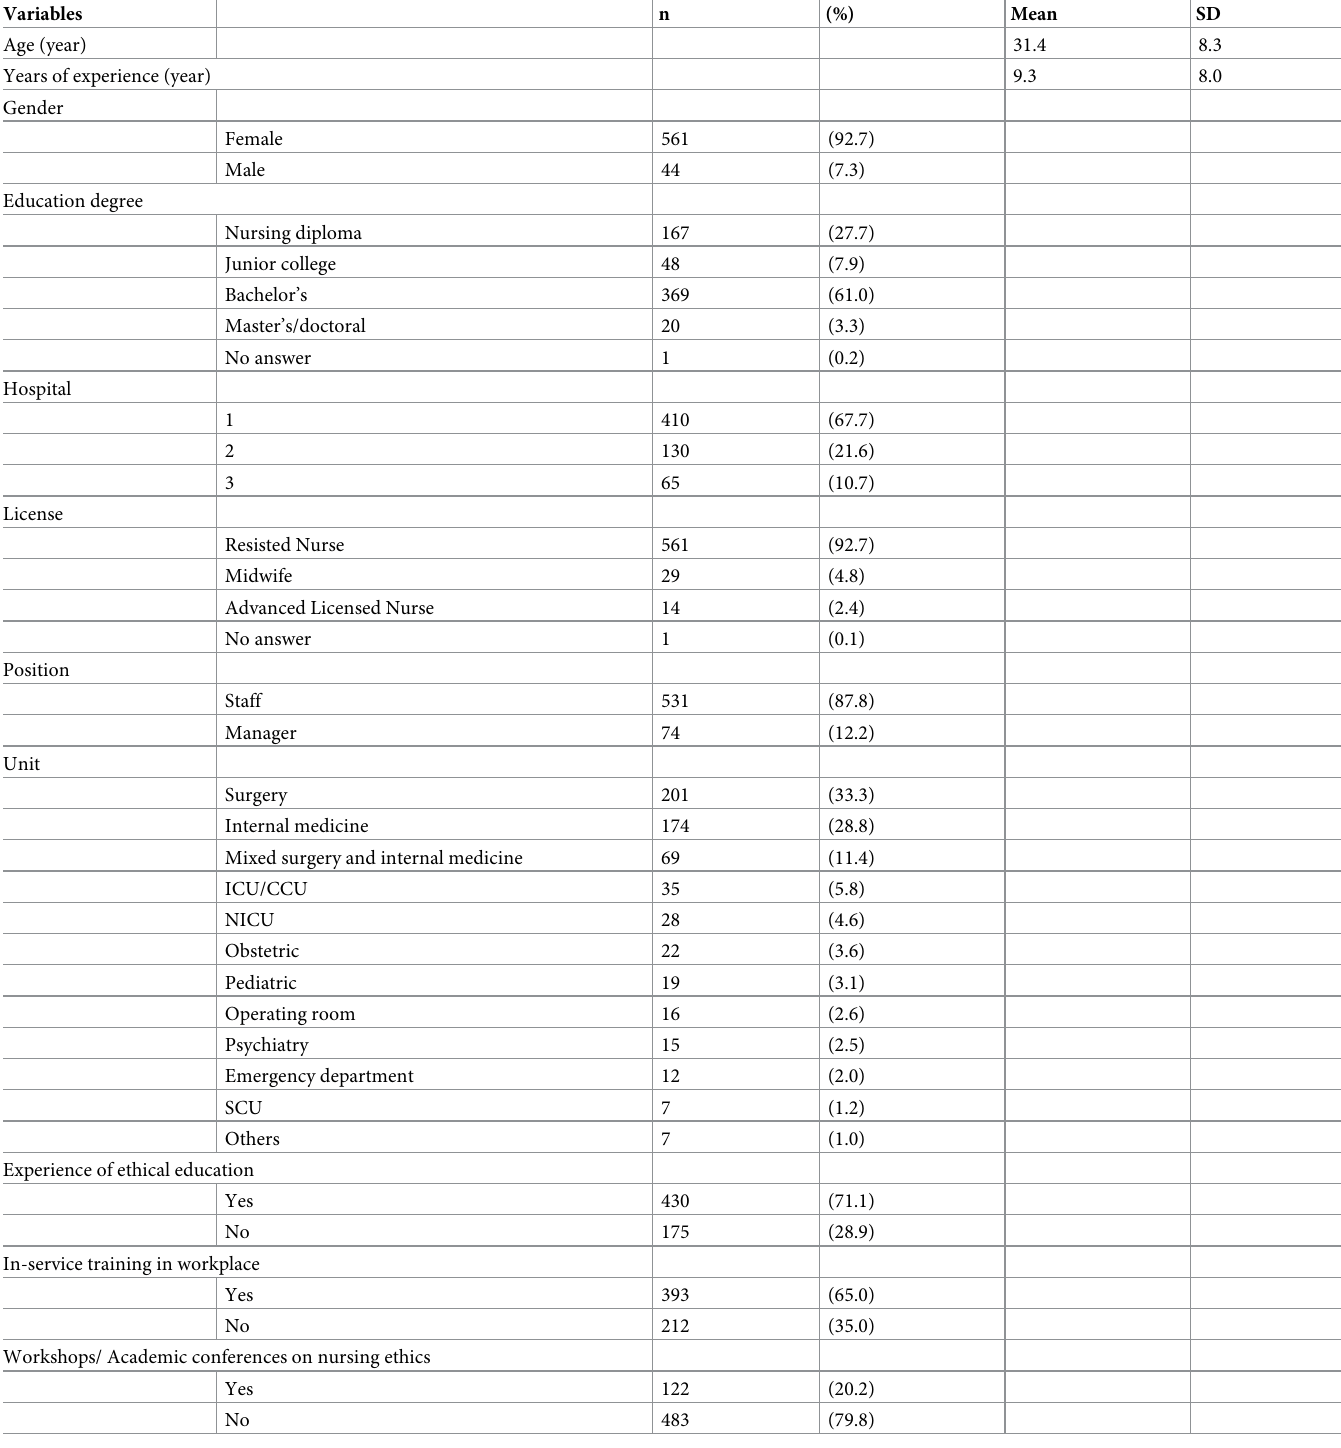
Table 1. Demographic characteristics (n =